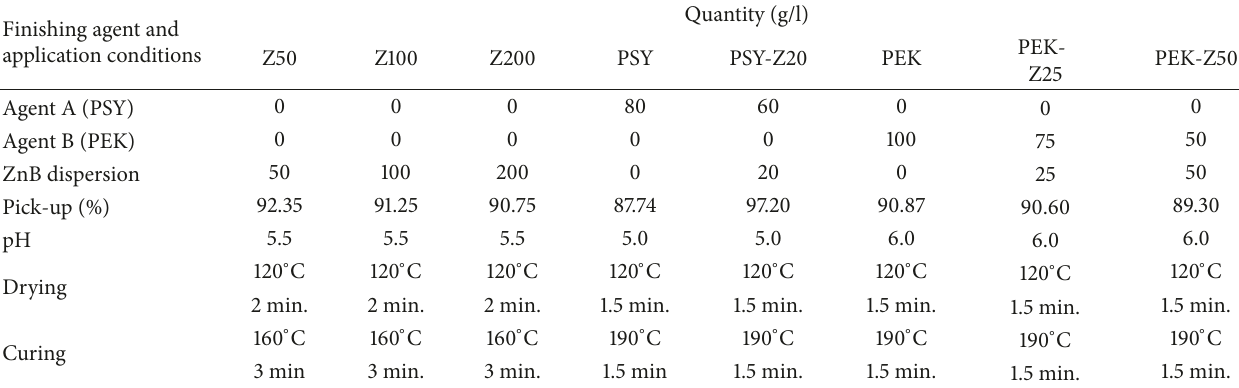
Table 1: The flame retardant treatment conditions of PET